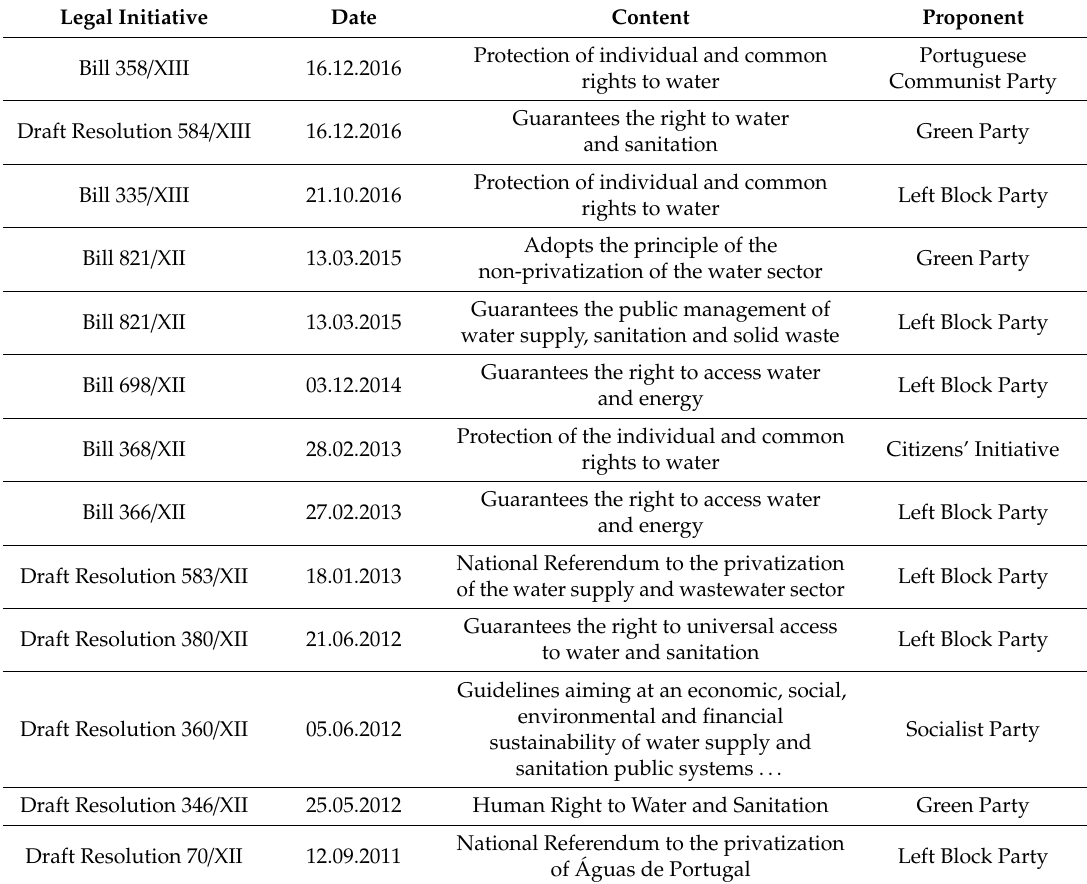
Table 2. Legal initiatives with an explicit reference to the HRtW.